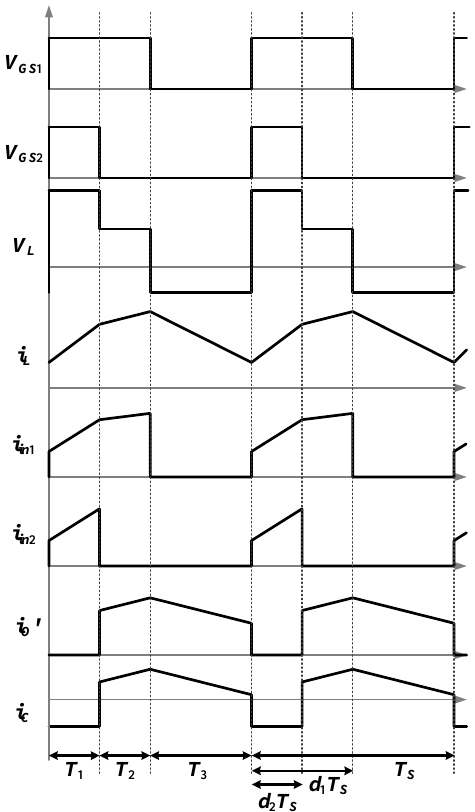
Figure 5. Theoretical waveforms of the discharging scenario.